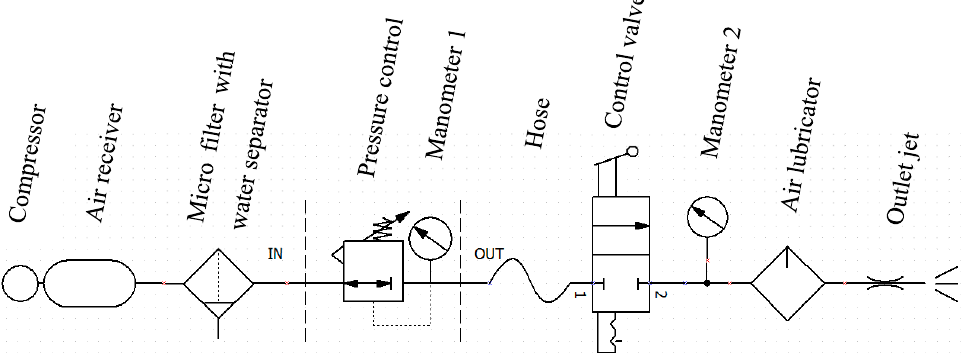
Figure 14. Simplified pneumatic wiring diagram for experimental measurement [23].